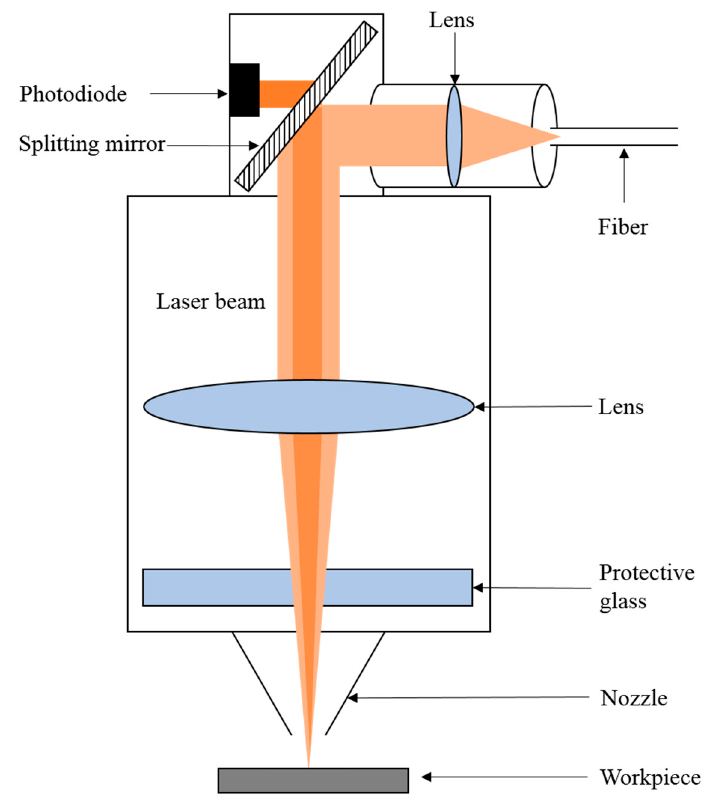
Figure 1. Schema of the experiment for the employed cutting head.